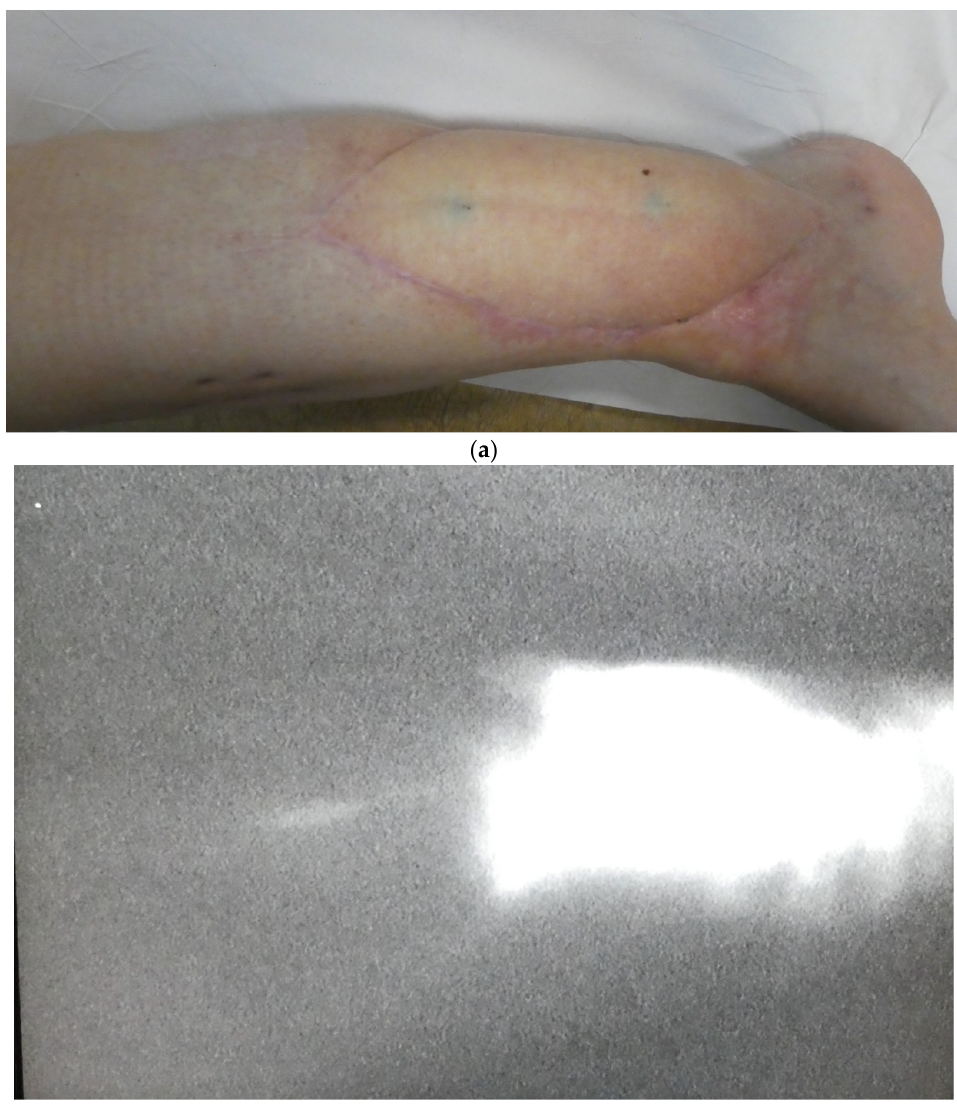
Figure 2. ( a ) Post-traumatic reconstruction with ALT flap using ICG guided flap design (one-year post-operative aspect). ( b ) ICG. Lymphatic connection between the flap and the recipient site is visible at the one year follow-up.